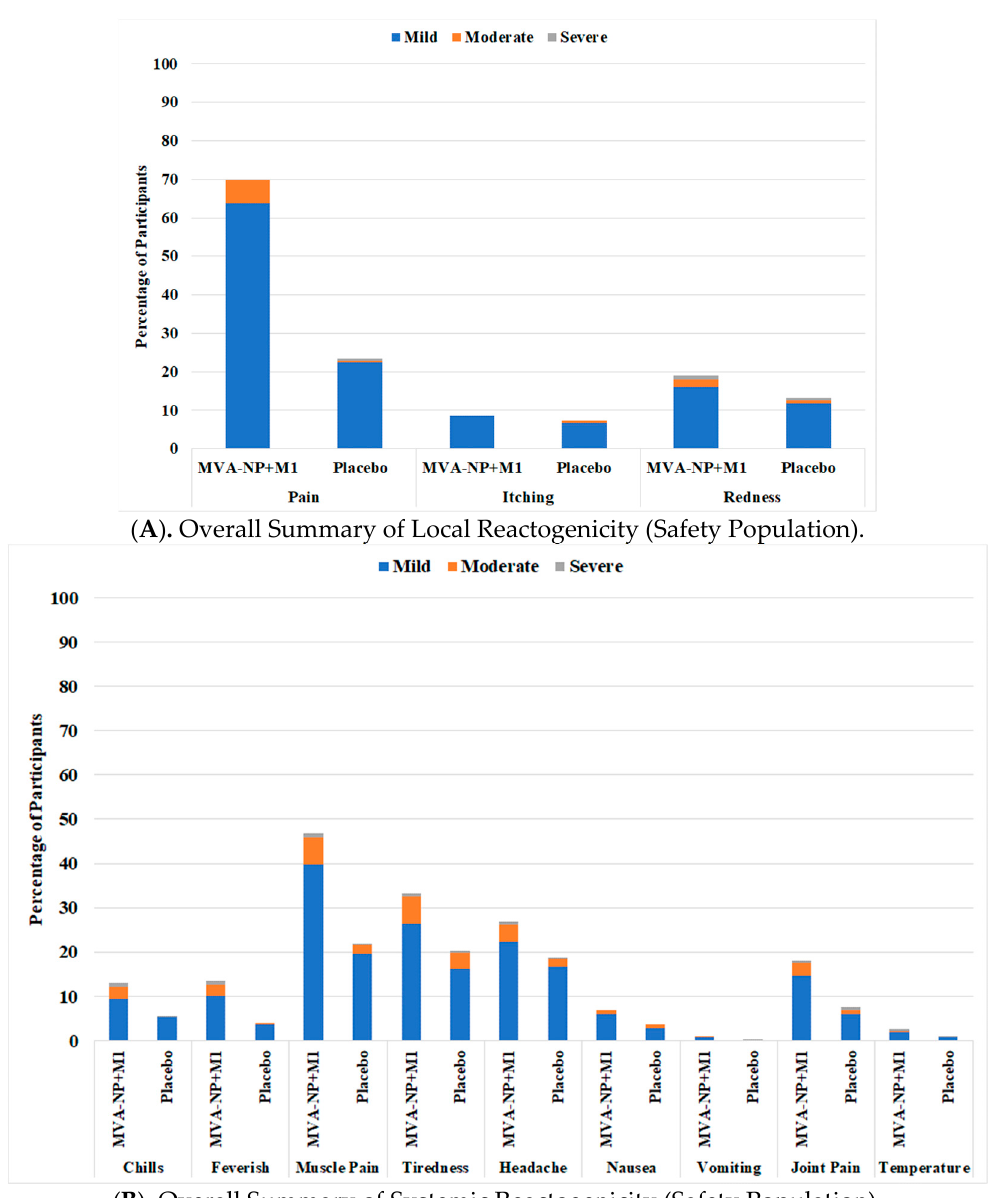
Figure 2. Local ( A ) and Systemic ( B ) reactogenicity in the 7 days following vaccination as recorded on patient diary